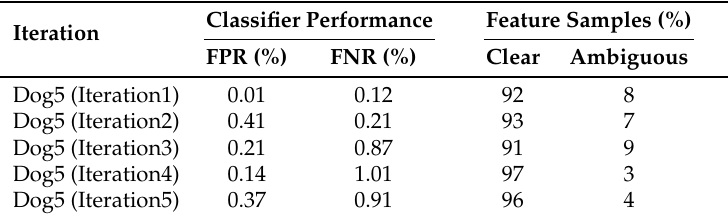
Table 13. Performance of the Support Vector Machine classifier in terms of False Positive Rate (FPR) and False Negative Rate (FNR) with Dog5 Inter-ictal dataset using set t feature